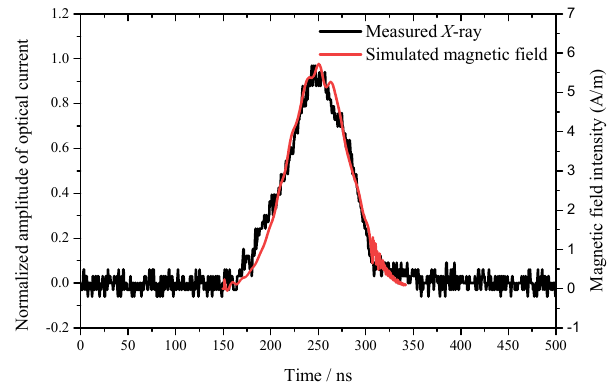
Figure 2. X − ray waveform and SGEMP simulation Figure 2. X−ray waveform and SGEMP simulation waveform. Figure 2. X−ray waveform and SGEMP simulation waveform.